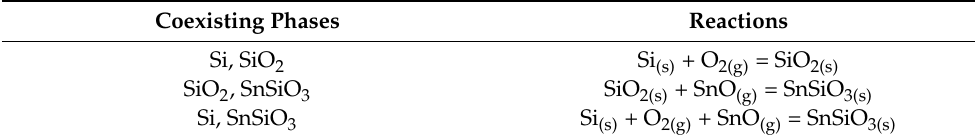
Table 2. Phase equilibriums in Sn–Si–O system.